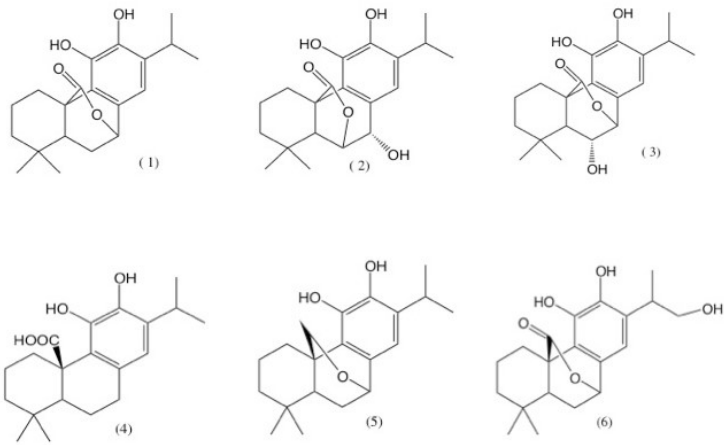
Figure 3. Abietanic diterpenes: carnosol ( 1 ), rosmanol ( 2 ), isorosmanol ( 3 ), carnosic acid ( 4 ), 20-deoxocarnosol ( 5 ), and 16-hydroxycarnosol ( 6 ).